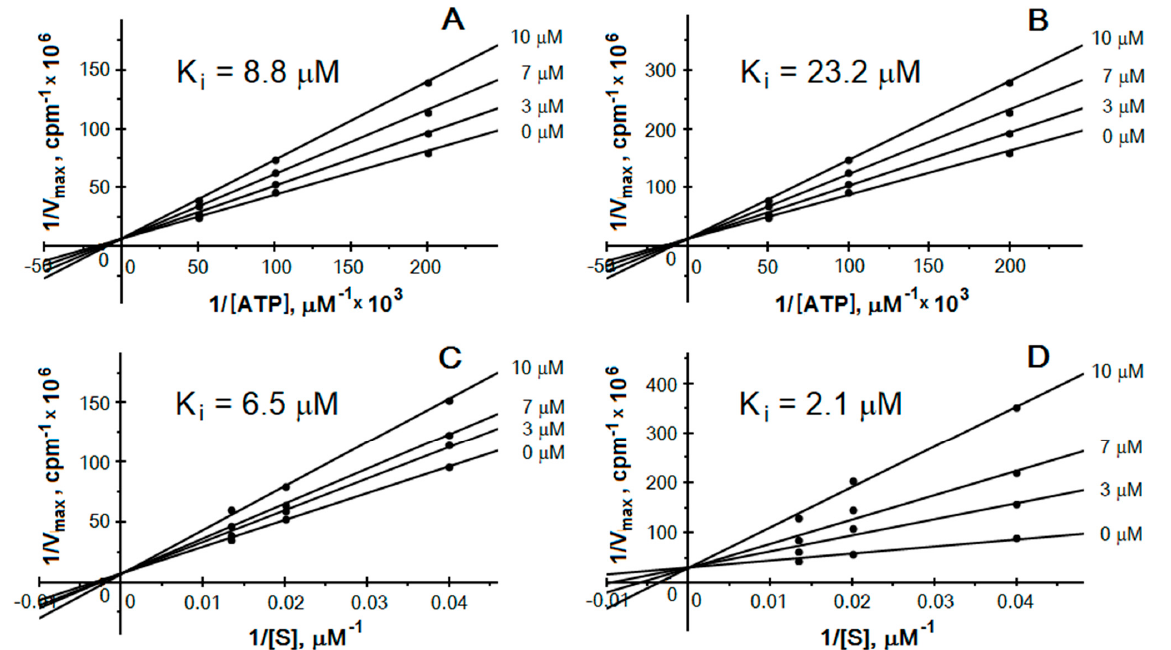
Figure 6. Inhibition of CK2 by Asf1. Lineweaver–Burk double reciprocal plots of CK2 α ( A , B ) and CK2 α ’ ( C , D ) inhibition obtained in the absence and in the presence of the indicated full-length Asf1 ( A , C ) and Asf1 170-79 ( B , D ) concentrations.